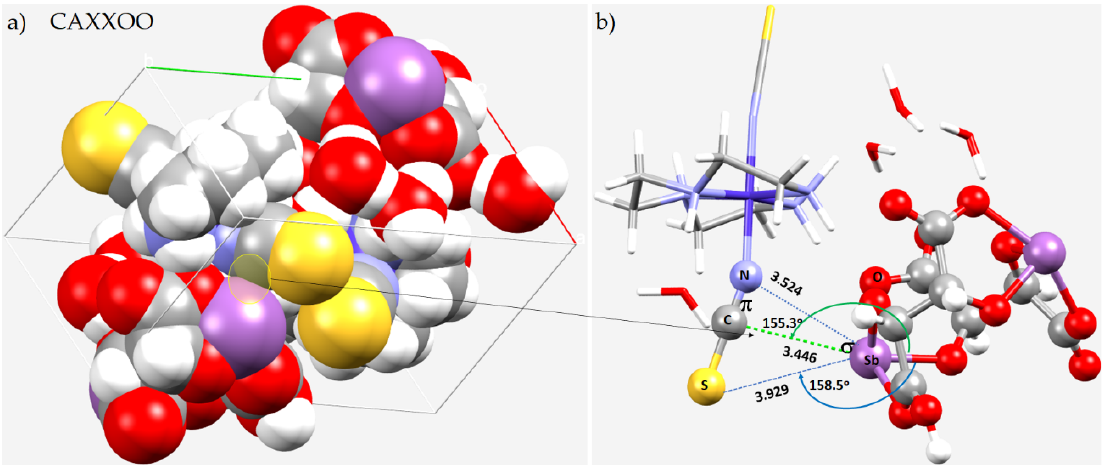
Figure 16. ( a ) The space-filling model of crystalline [Co(trien)(NSC) 2 ][Sb 2 (tart)(Htart)], CSD ref. code CAXXOO. ( b ) The ball-and-stick model of the same structure, showing atom type and highlighting the possibility of π -centered non-covalent interactions. Bond lengths and bond angles are in Å and degree, respectively. Atoms are shown as small spheres and bonds as lines in atom color, whereas the intermolecular interactions are represented by dotted lines.